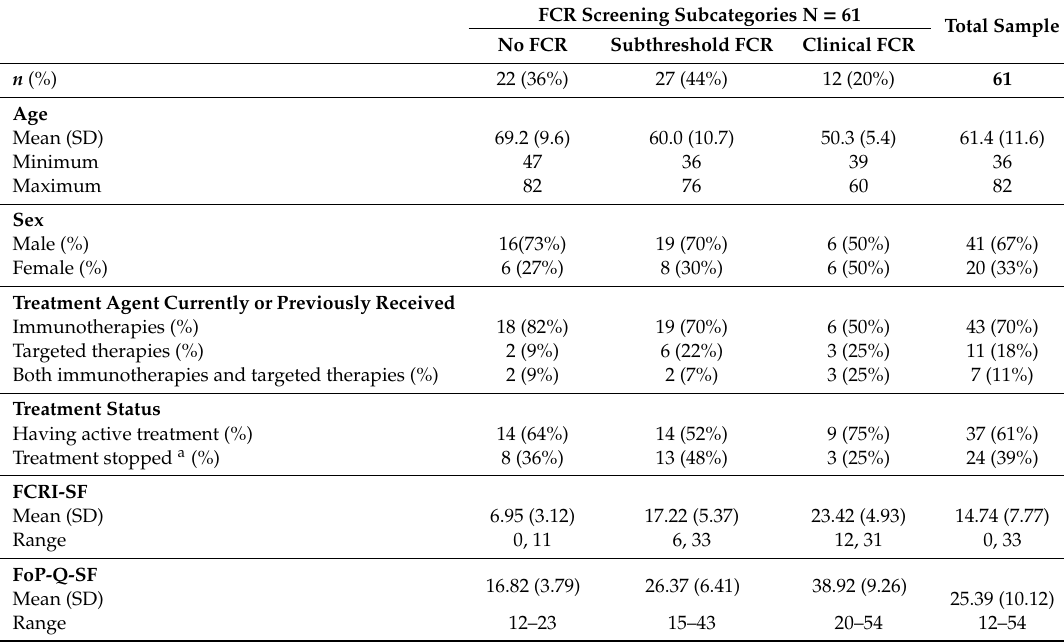
Table 1. The sample was primarily male (41, 67%), on active treatment (37, 61%) and treated with